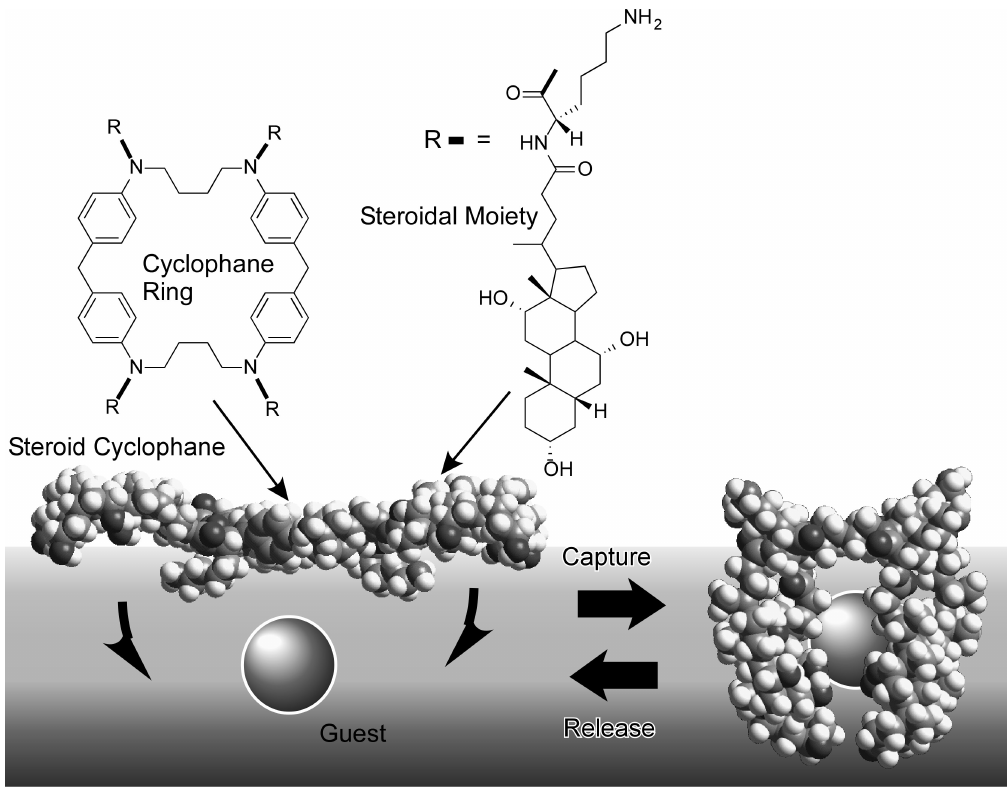
Figure 5. Dynamic molecular recognition by steroid cyclophane at the air-water interface. Reprinted with permission from [54] ©2006, Royal Society of